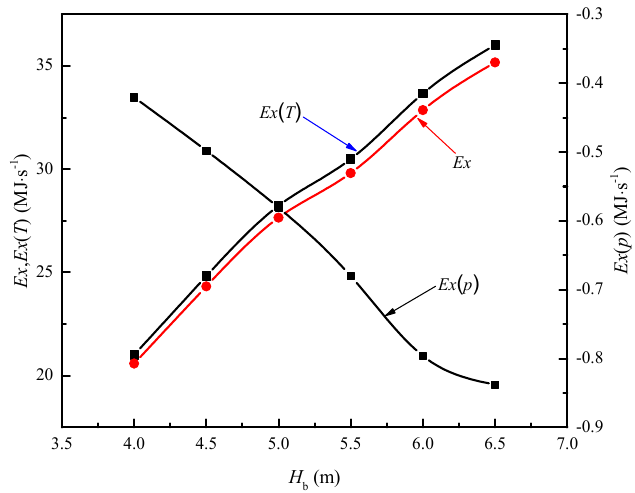
Figure 14. Effects of the height of the sinter bed on enthalpy exergy Ex , temperature exergy Ex ( T ), and pressure exergy Ex ( p ).